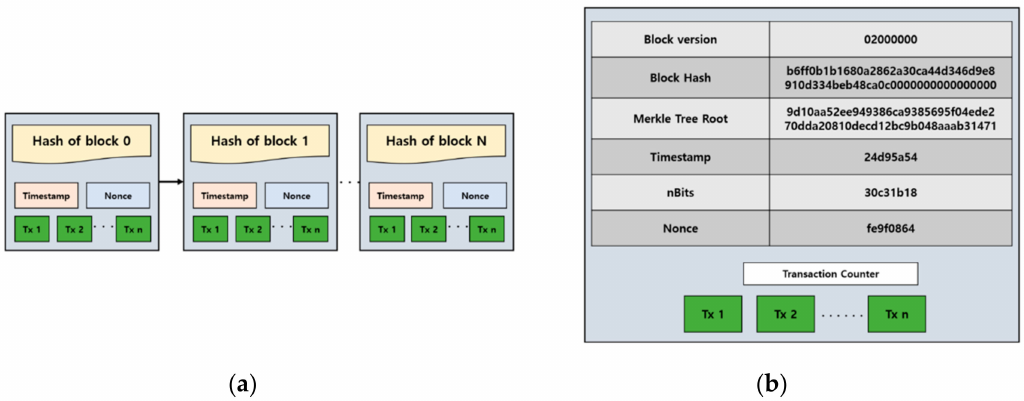
Figure 1. ( a ) Configuration of the blockchain; ( b ) internal structure of a block in the